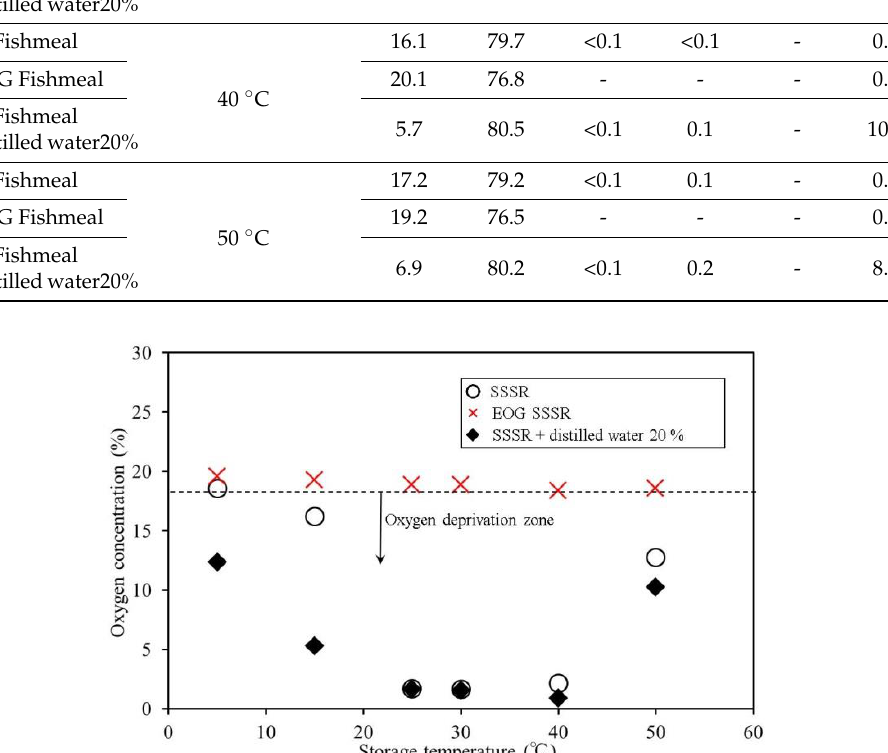
Figure 18. Oxygen concentrations as functions of storage temperature for SSSR samples.